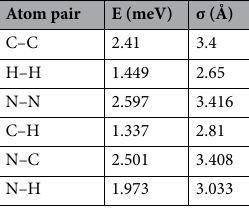
Table 1. Lennard–Jones interaction parameters 46–49